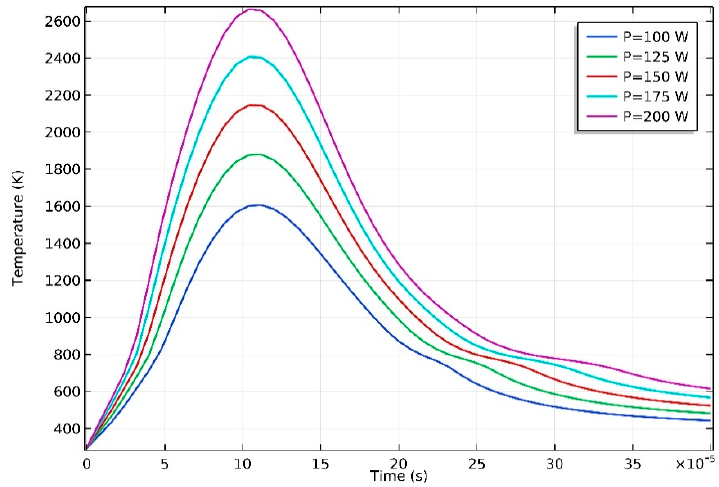
Figure 6. Temperature of point B with time.